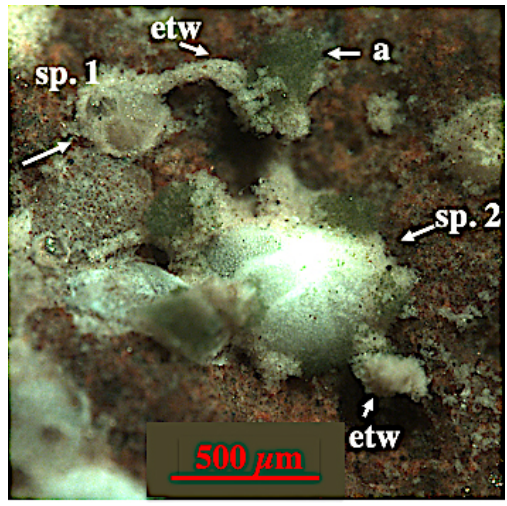
Figure 12. Epilithic C. lobatulus specimen from off Svalbard. A joined “agglutinated” tube, here equated with ectoplasmic twigs, is developed between specimen 1 and 2. Algae are accumulated halfway down the tube. “etw” denotes ectoplasmic twig; “a” de- notes algae. Picture courtesy of Julia Wukovits (September